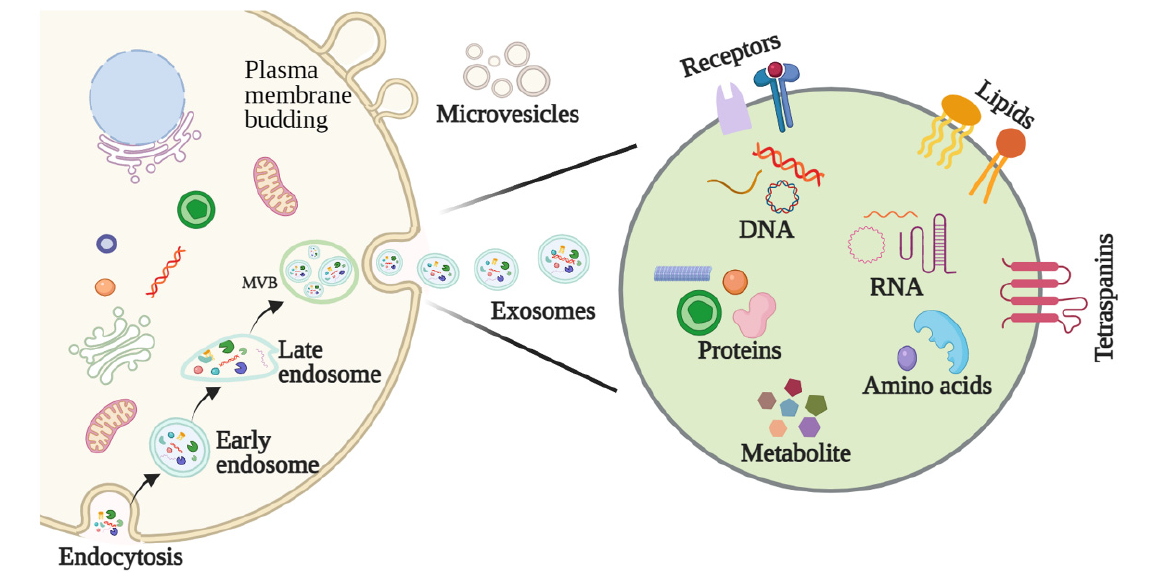
Figure 1. Schematic presentation of the process by which exosomes are produced and released from the cell to the TME.